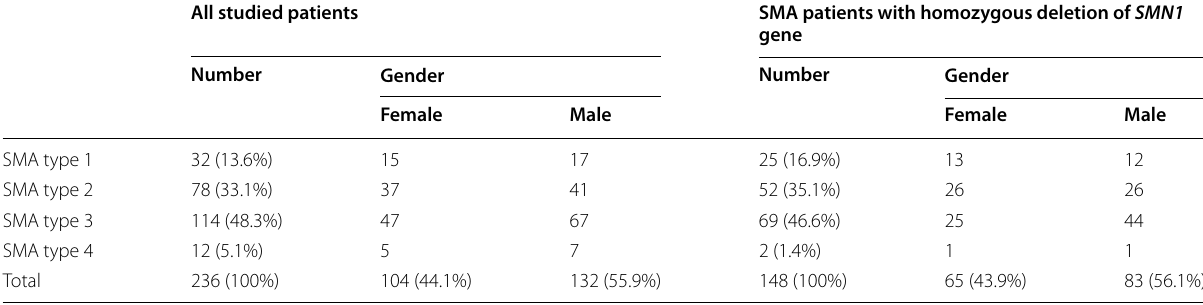
236) and the patients with confirmed molecular diagnosis (n =